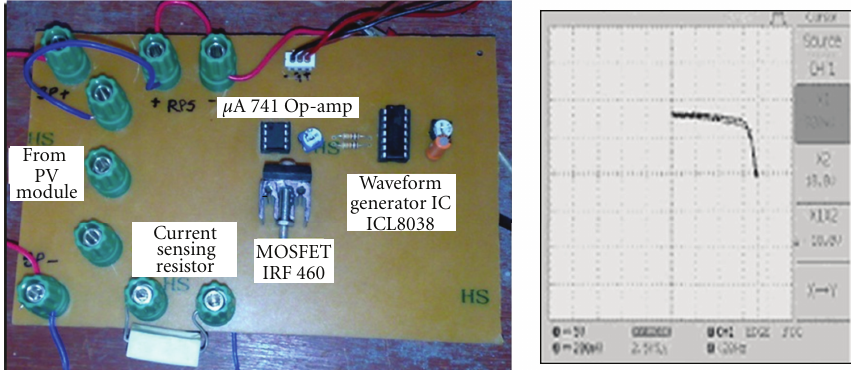
Figure 9: Hardware setup of an electronic load with sample snapshot of DSO screen for V-I